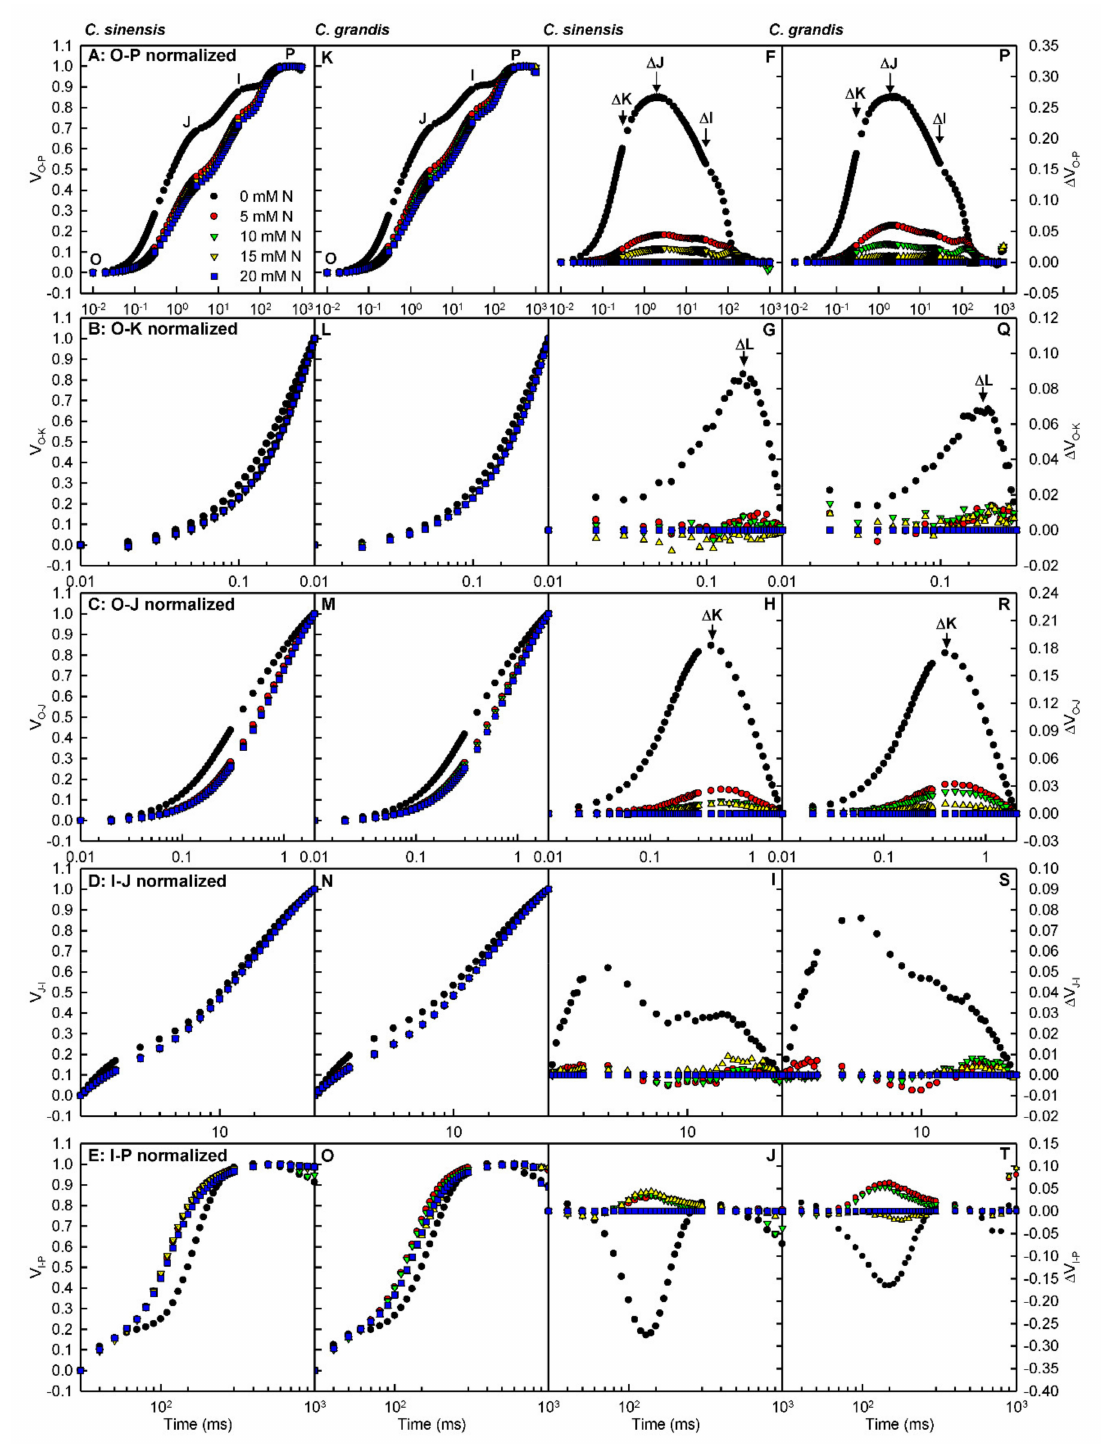
Figure 8. Effects of N supply on the mean OJIP transients of 10 measured samples expressed as the kinetics of relative variable fluorescence: between F o and F m (O-P normalized): V O-P = (F t − F o )/(F m − F o ) ( A , K ) and the differences of the five samples to the reference sample treated with 20 mM N ( ∆ V O-P ; F , P ); between F o and F 300 µ s (O-K normalized): V O-K = (F t − F o )/(F 300 µ − F o ) ( B , L ) and the differences of the five samples to the reference sample ( ∆ V O-K ; ( G , Q )); between F o and F J (O-J normalized): W O-J = (F t − F o )/(F J − F o ) ( C , M ) and the differences of the five samples to the reference sample ( ∆ V O-J ; ( H , R )); between F J and F I (J-I normalized): W J-I = (F t − F J )/(F I − F J ) ( D , N ) and the differences of the five samples to the reference sample ( ∆ V J-I ; ( I , S )); and between F I and F m (I-P normalized): V I-P = (F t − F I )/(F m − F I ) ( E , O ) and the differences of the five samples to the reference sample ( ∆ V I-P ; ( J , T